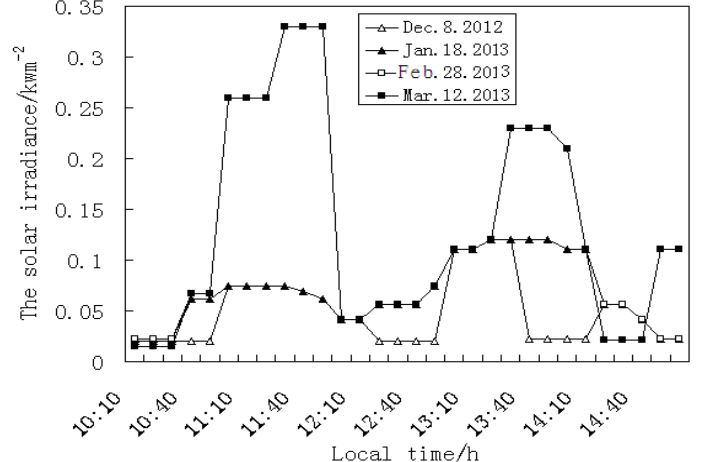
Figure 6. Amount of solar irradiance (kW/m 2 ) over time (plotted in 10-min increments) on days which were intermittently sunny and